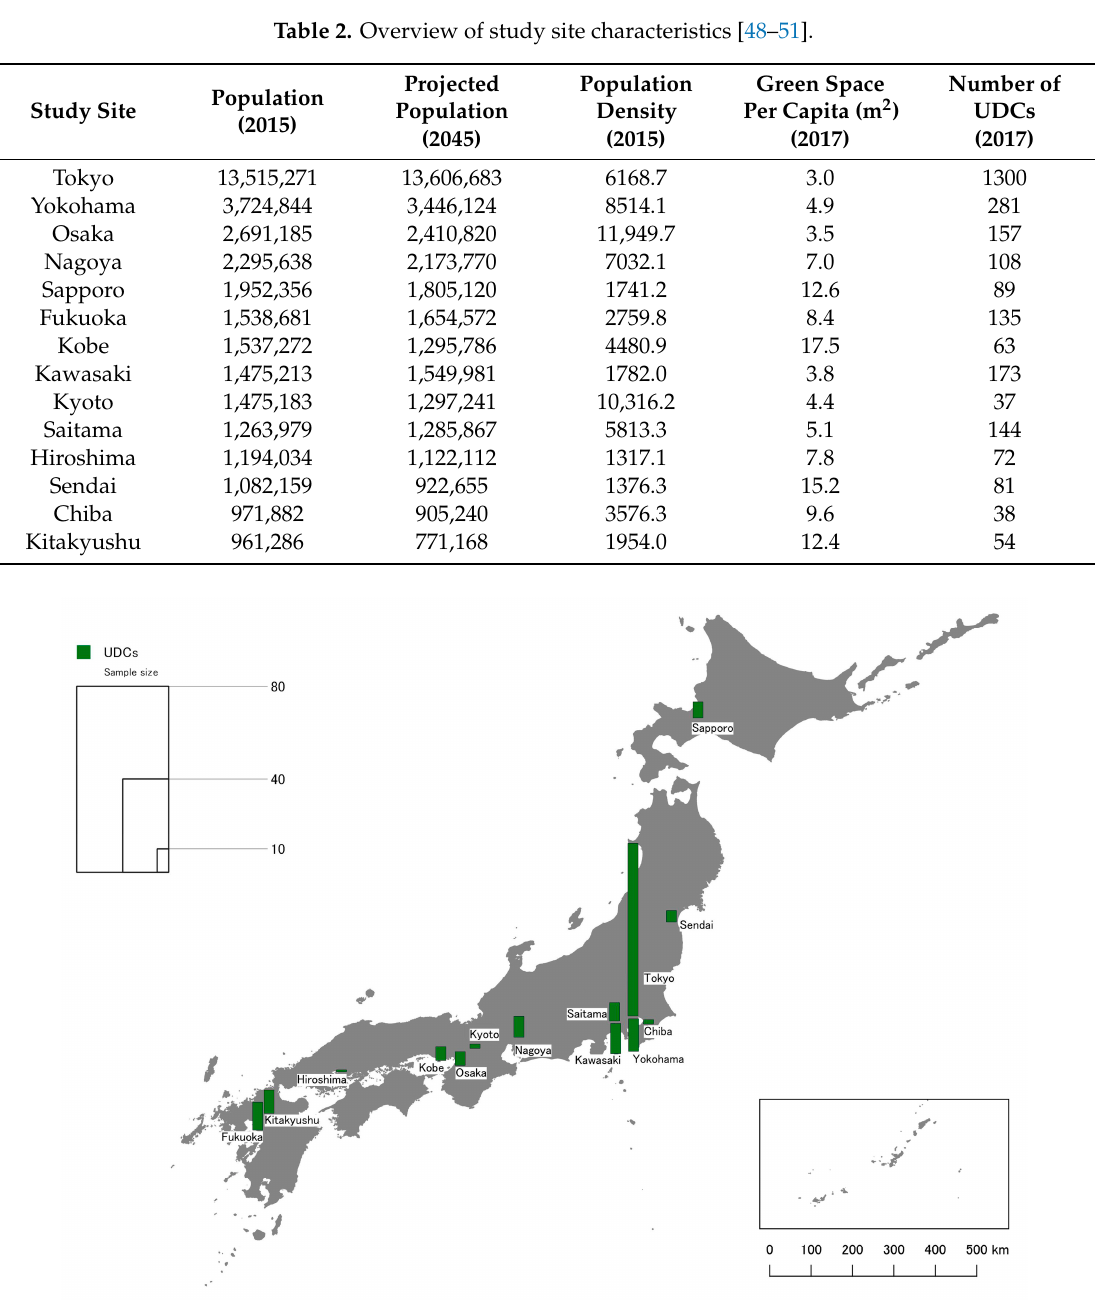
Figure 2. Study site locations and data samples for UDC survey.